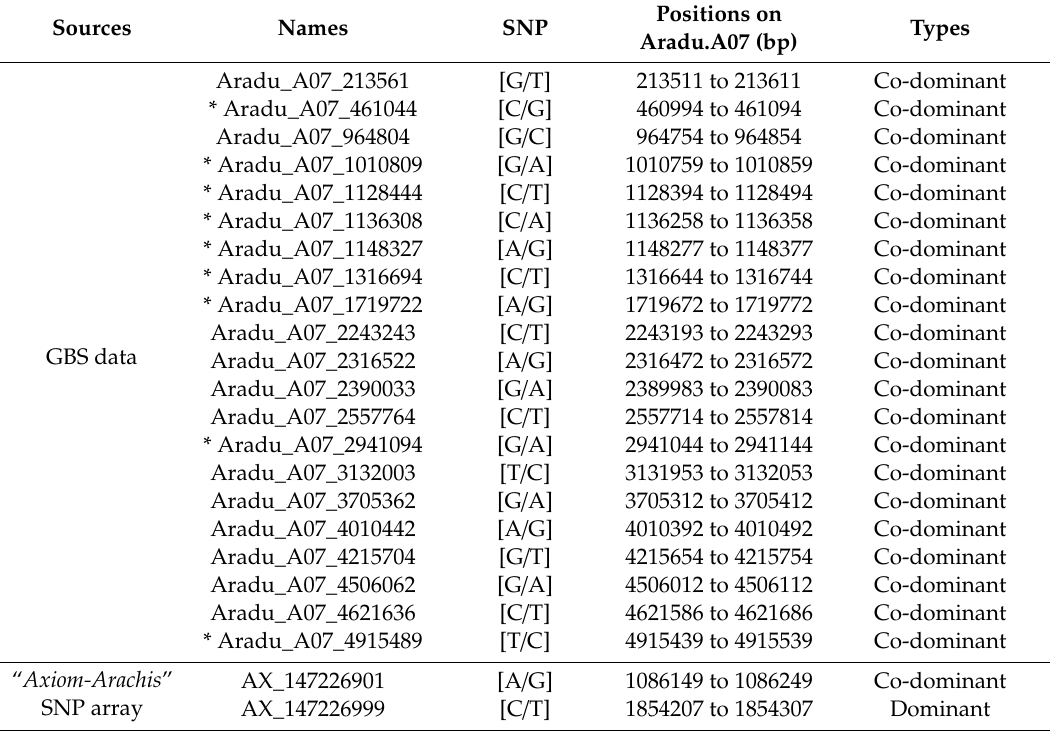
Table 1. Polymorphic SNPs developed in this